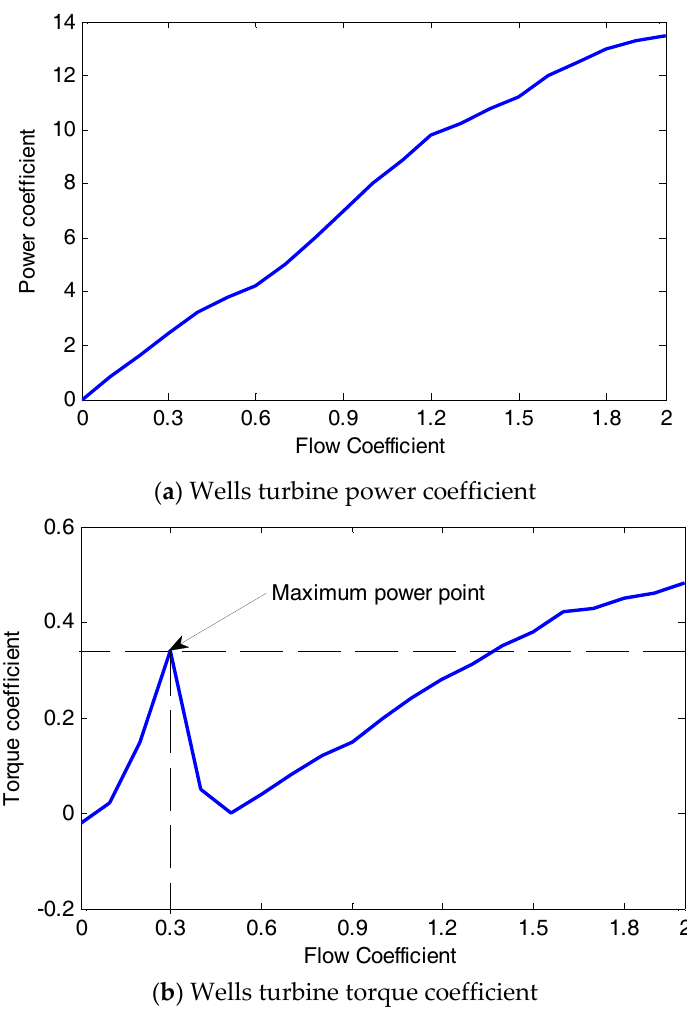
Figure 4. Characteristics of Wells turbine [26].